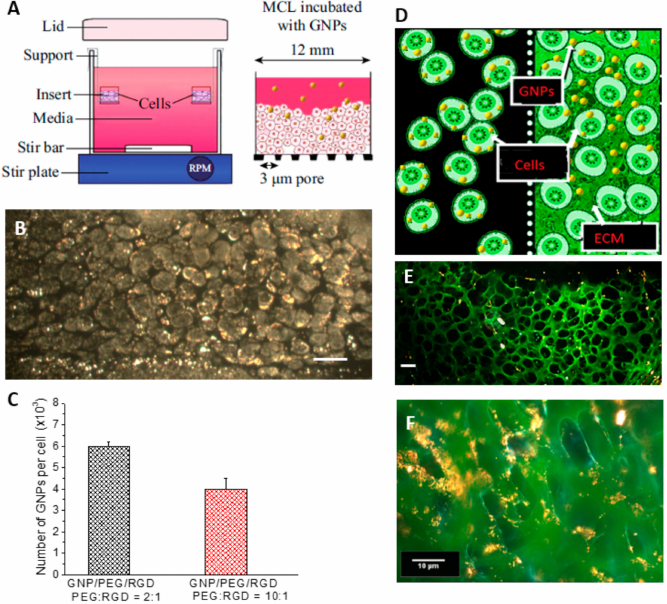
Figure 4. ( A ) Setup of multilayer model (MCL); ( B ) Dark field image of MCL. Scale bar = 10 µ m; ( C ) Accumulation of GNP constructs in MCL; ( D ) Illustration of the comparison of GNP accumulation in monolayer (left) and MCL (right). ECM = extracellular matrix; ( E ) MCL stained with eosin. Scale bar = 10 µ m; ( F ) MCL stained with eosin. Scale bar = 10 µ m.